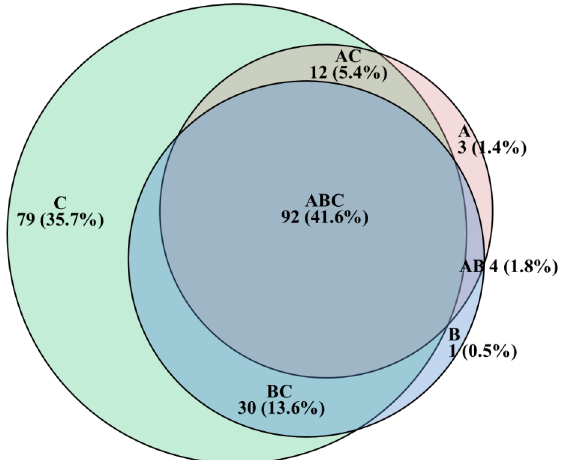
Fig 1. Venn diagram showing the distribution of samples which resulted positive in at least one of the assays performed (n = 221). (A) virus neutralization (VN); (B) gB ELISA; (C) Nucleic acid detection (NAD) by